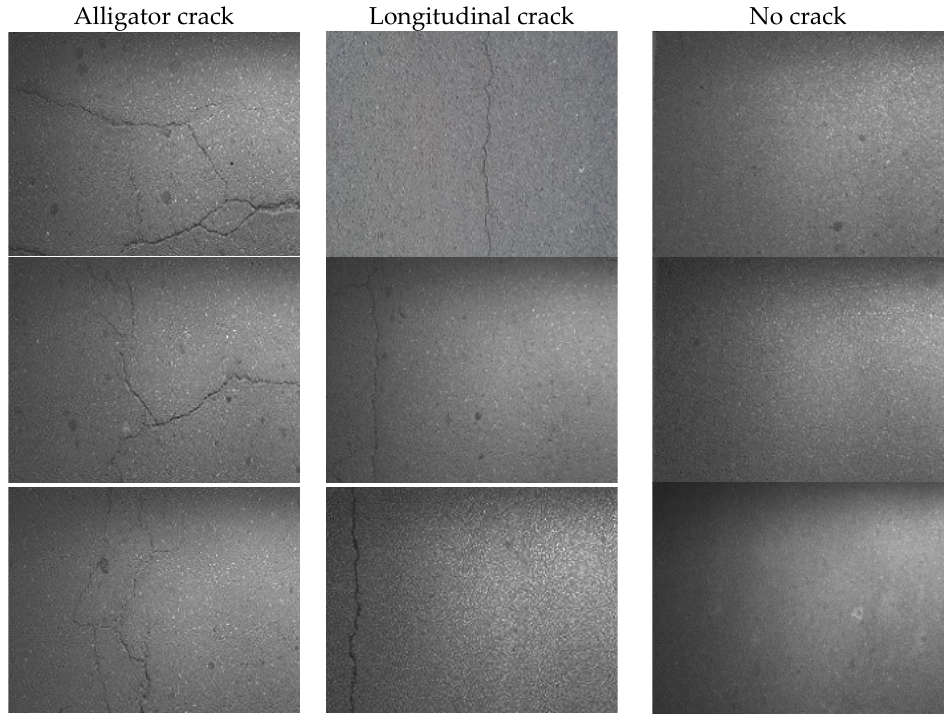
Figure 2. Example of the three road classes. Table 1. Types of road cracks. Table 2. Number of images used for training, validation and